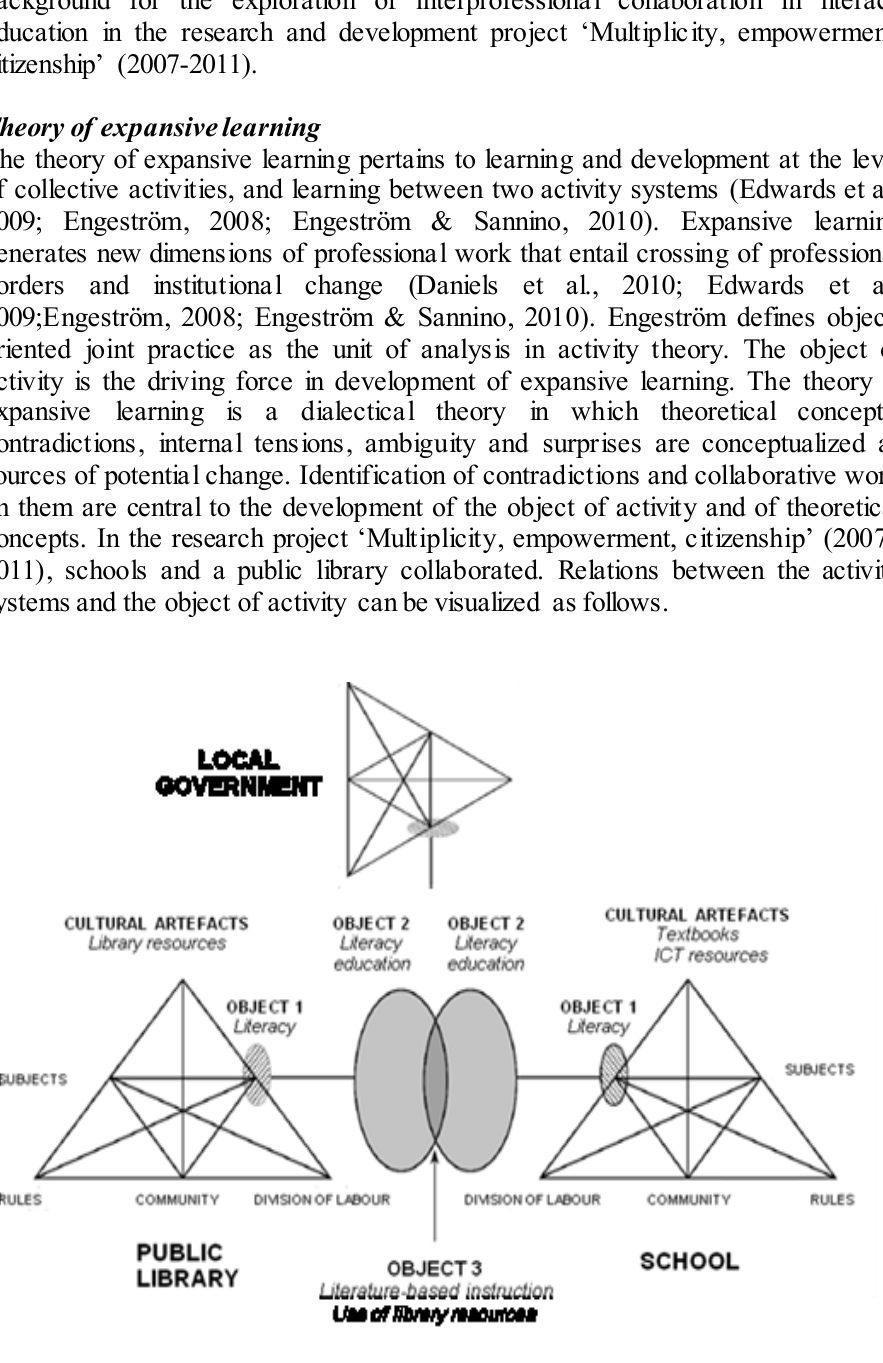
Fig. 1 The figure shows relations between two activity systems in the